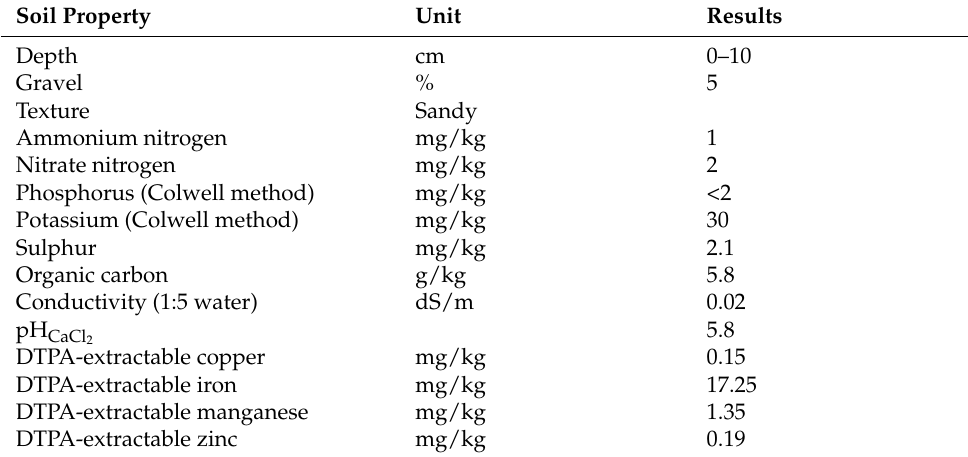
Table 1. Physical and chemical properties of the